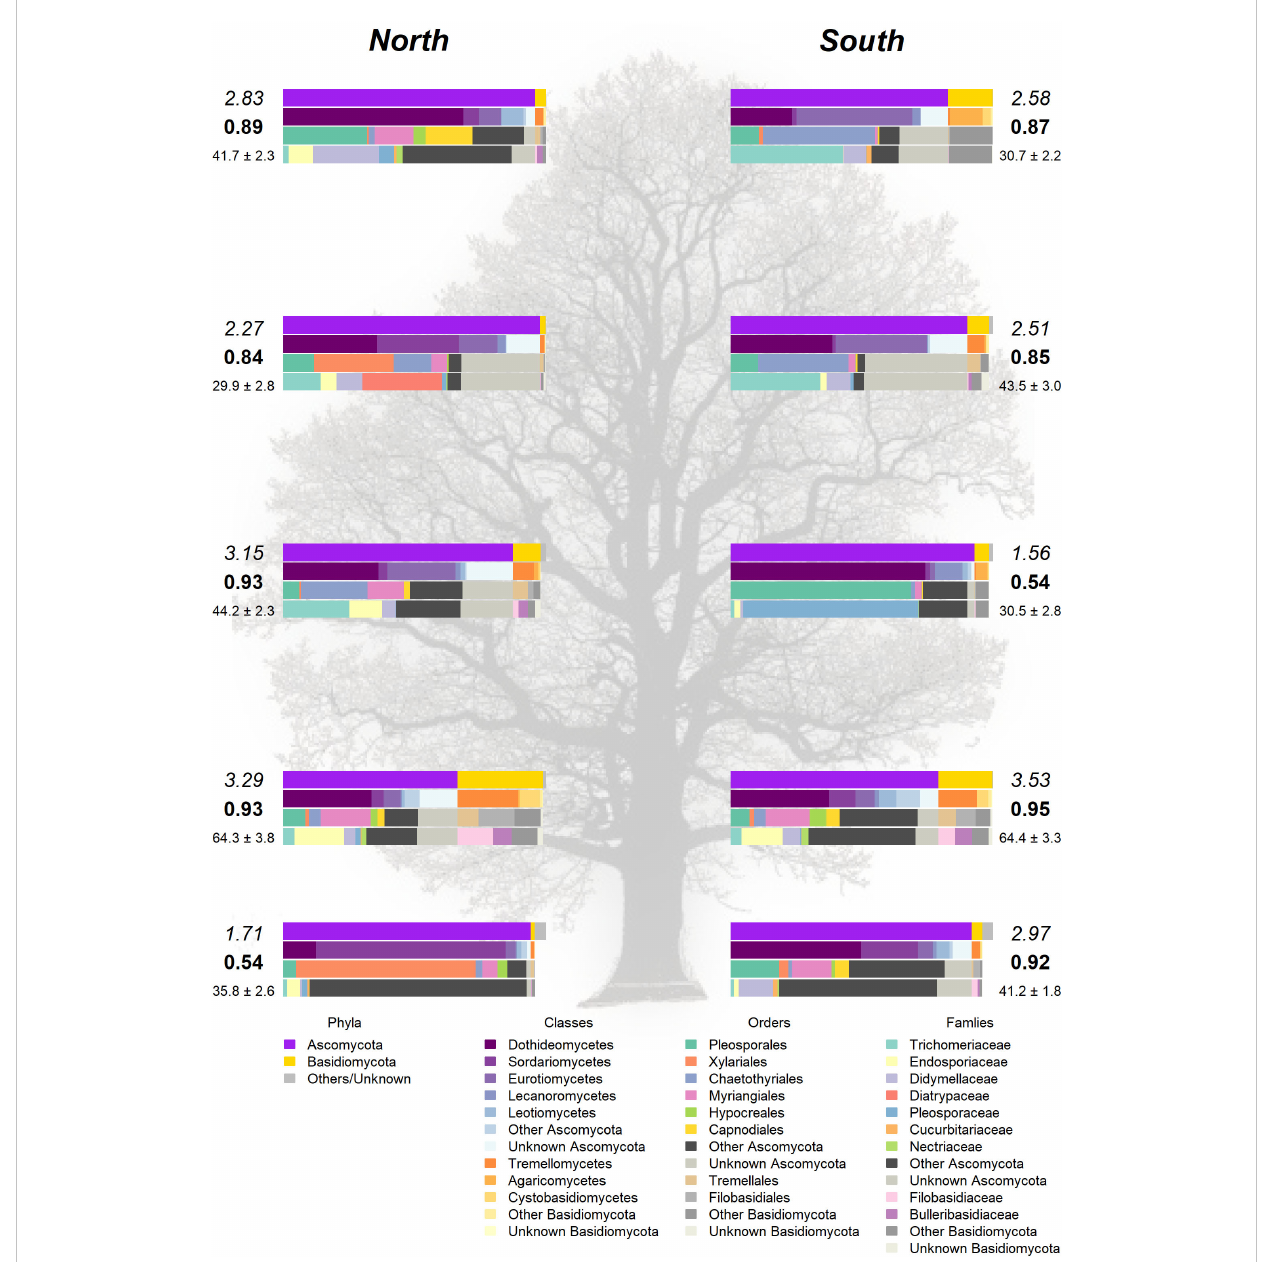
FIGURE 4 Taxonomic composition in the landmark tree. Only the most relevant taxa are shown. Colored bars represent the frequency of taxa at the levels of phylum, class, order and family (top to bottom). Numbers next to the bars indicate the Shannon (italics) and Simpson (bold) indices and the OTU richness rarefacted to 500 reads (with standard error). (Background image source: Tree Silhouette copy by Bob G in fl ickr, licensed under CC BY- NC-SA